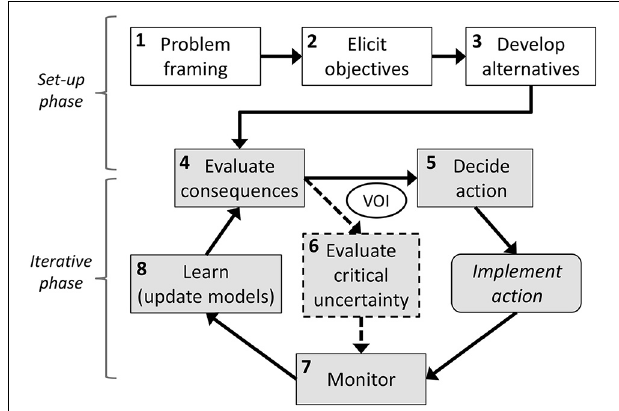
FIGURE 1 | Diagram of the main steps in adaptive management, as an iterative form of structured decision making (adapted from Runge, 2011), highlighting the two main phases. VOI stands for “ value of information analysis